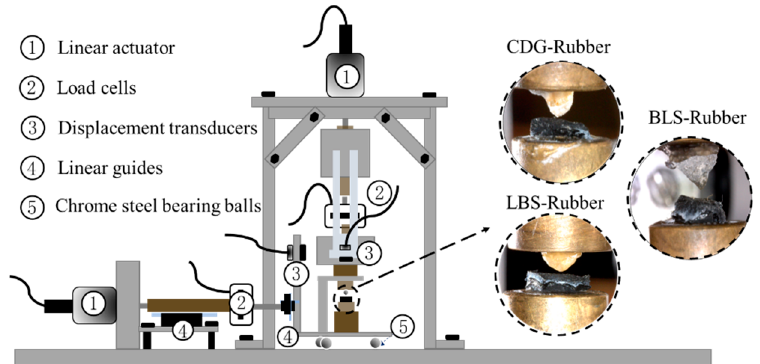
Figure 5. Schematic diagram of the testing apparatus and the testing materials.